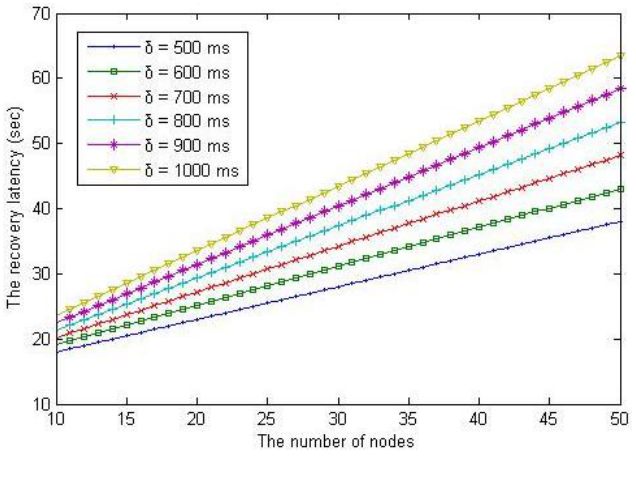
Figure 14. The recovery latency as the guard time ( δ